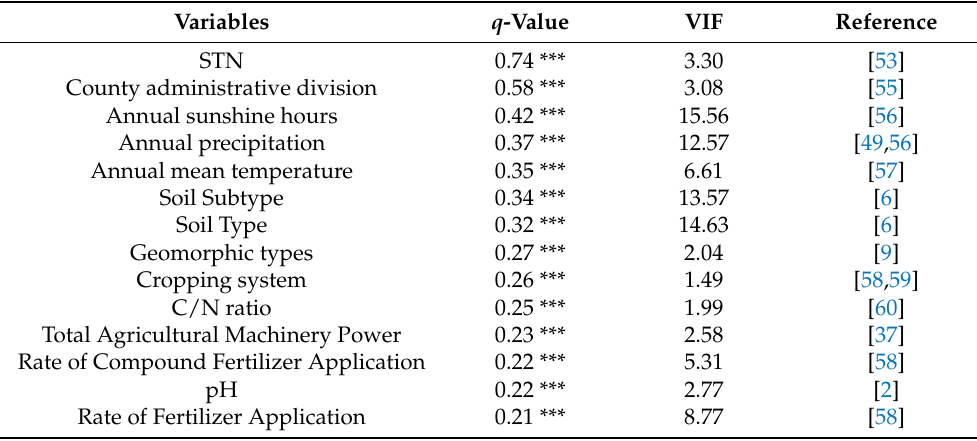
Table 1. Details of the effective variables from Geo-detector